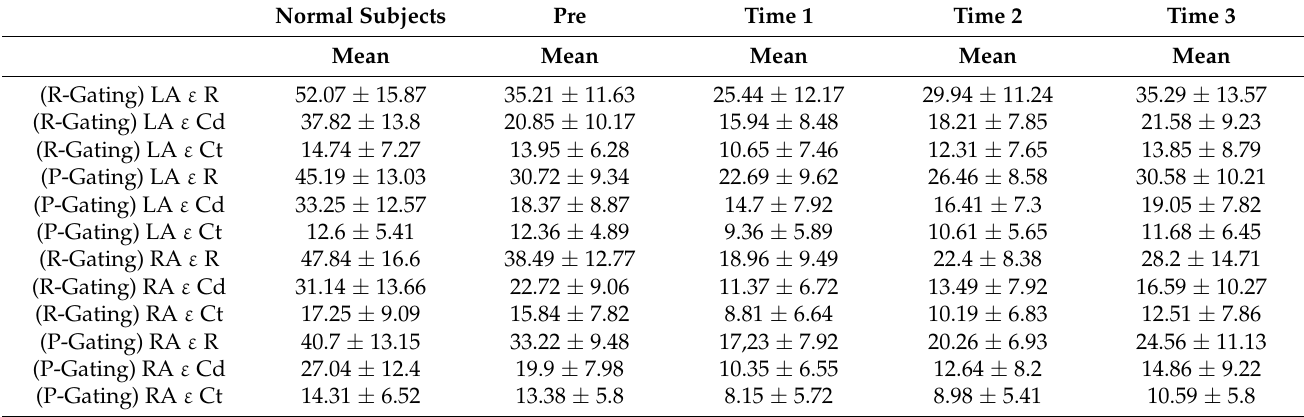
Table 3. Mean and standard deviations of examinations at different pre-/post-operative times and in control